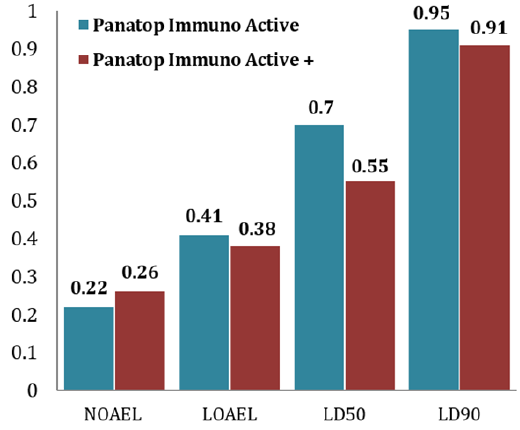
Figure 2. Comparison of toxicological indices of tested products towards Aphis pomi